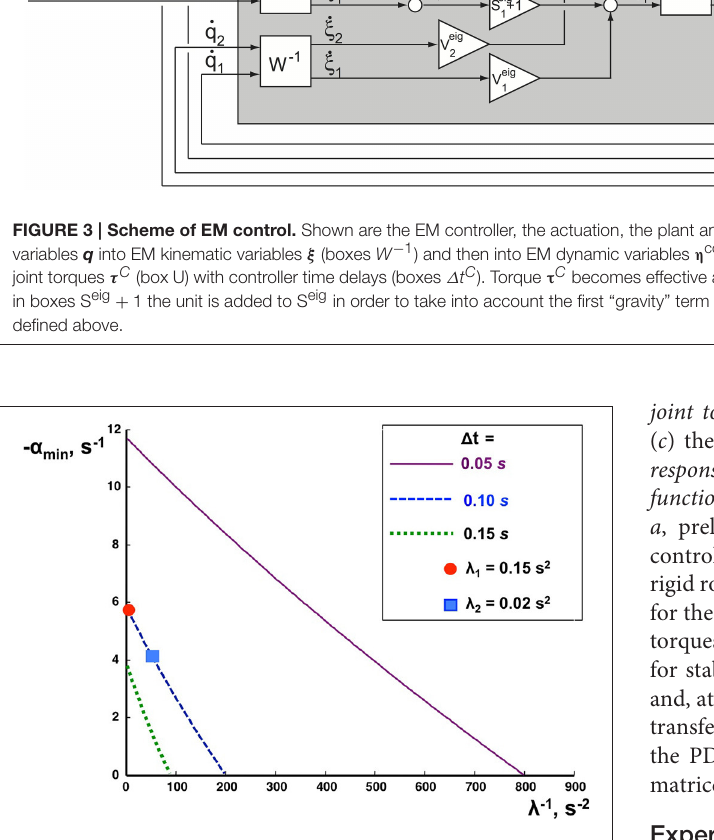
FIGURE 4 | Effects of feedback delay time on PD-control stability. The negative Lyapunov index α min (ordinate), is plotted as a function of the inversed index of inertia λ (abscissa) for different delay times 1 t as